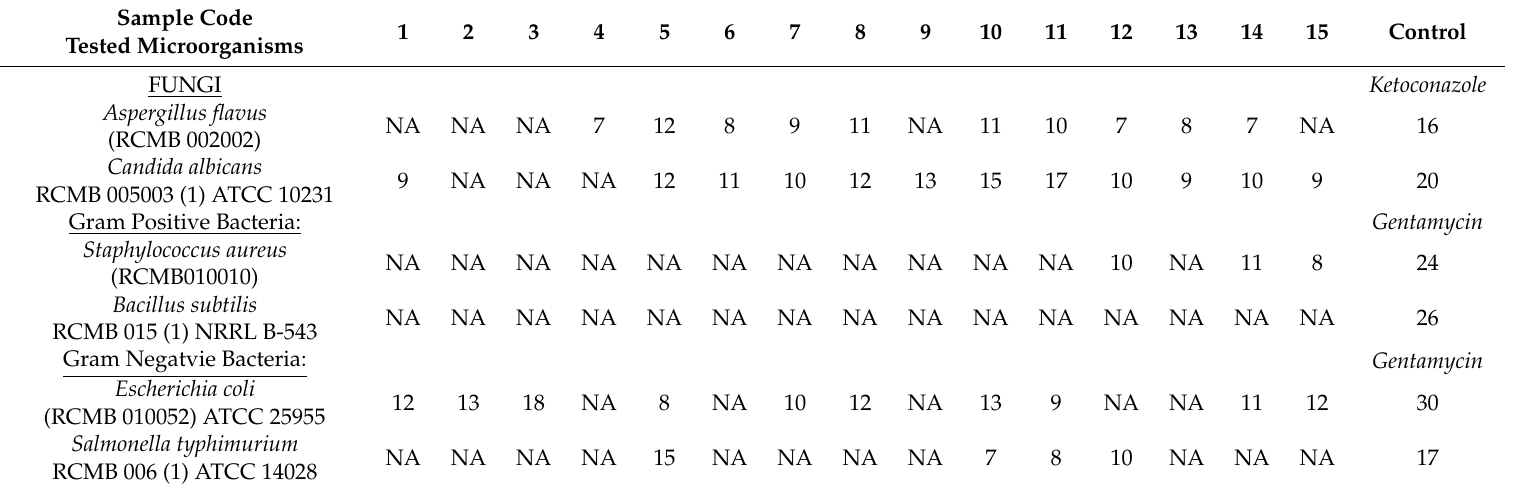
Table 2. Anti-microbial activities of newly synthesized compounds 1 – 15 . Sample